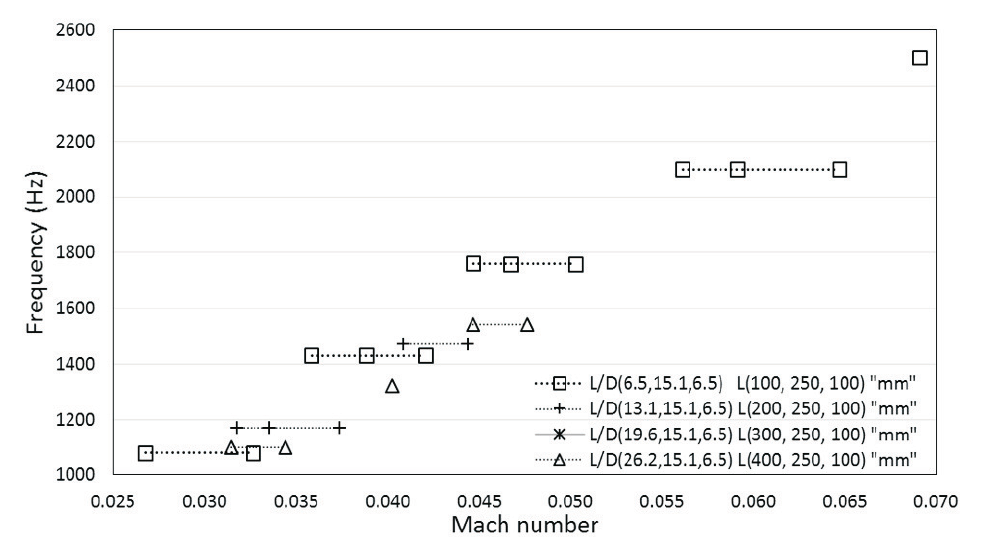
Figure 14. Frequency (Hz) plotted against Mach number M for L up = 100–400 mm, L corr = 250 mm, and L dw = 100 mm. Table 10. Mach number and corresponding frequency range (Hz) for pipe systems in Case b-I.